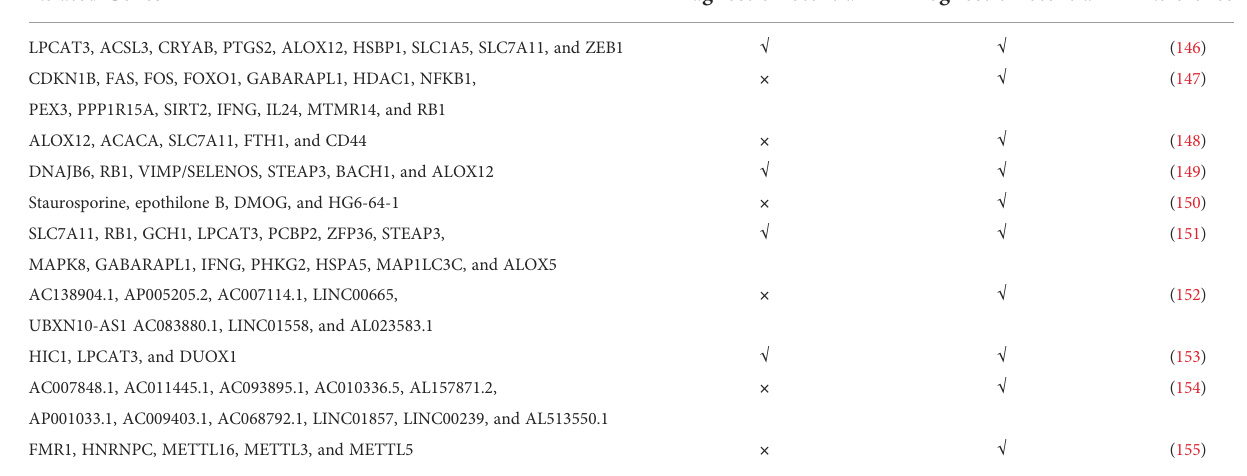
TABLE 2 Ferroptosis related genes in patients with ovarian cancer. Related